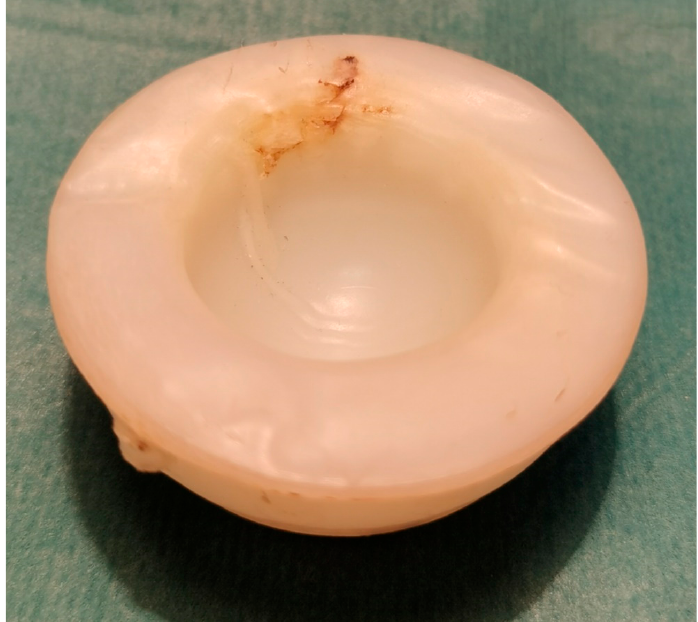
Figure 3. Creep and wear leading to deformation of the acetabular UHMWPE